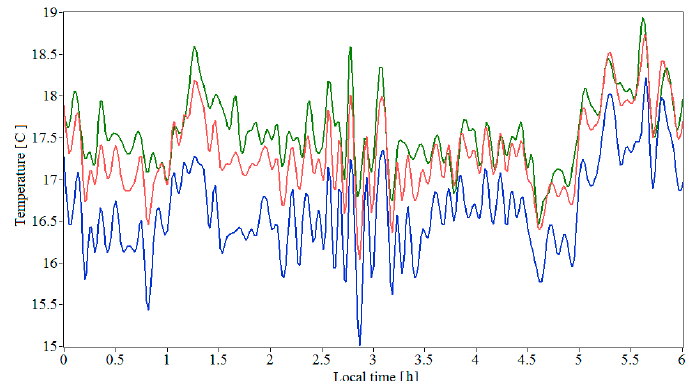
Figure 15. Time series of the air temperature at heights of 450 (green curve), 600 (red curve), and 750 m (blue curve), as obtained from the measurements by the temperature profiler on 23 August 2018.